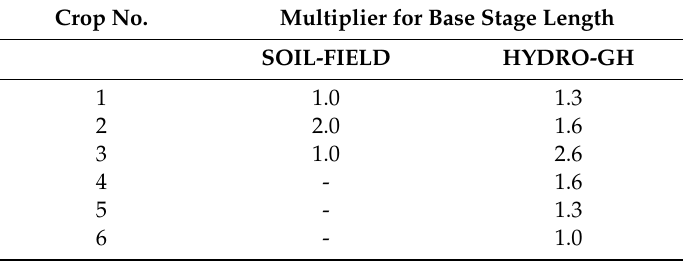
Table A4. Crop stage length multiplier to generate daily Kcb for a 365-day period.